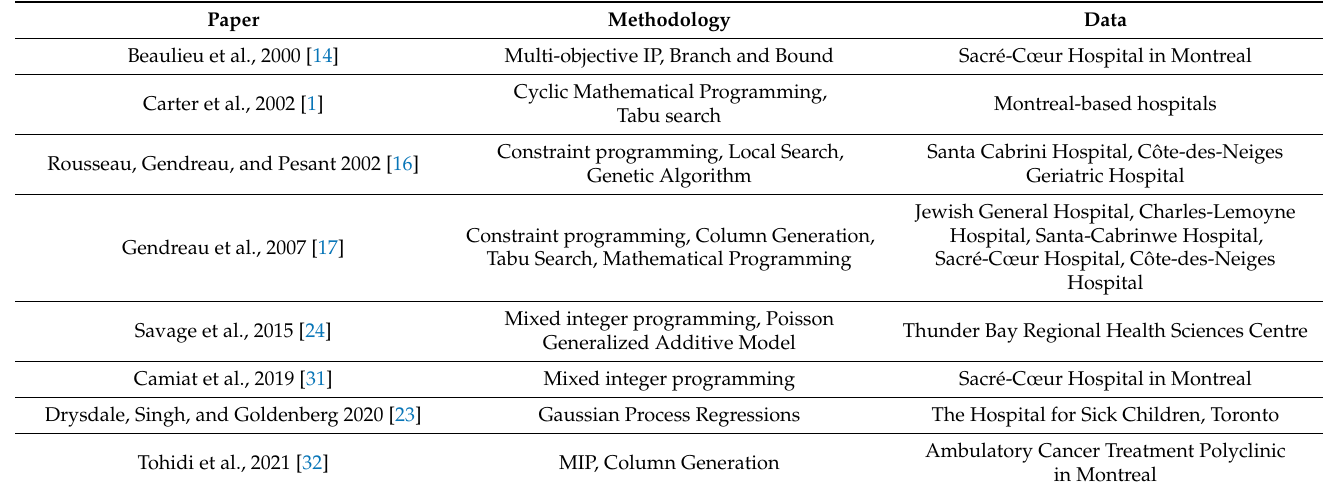
Table 3. Physician/Emergency Room